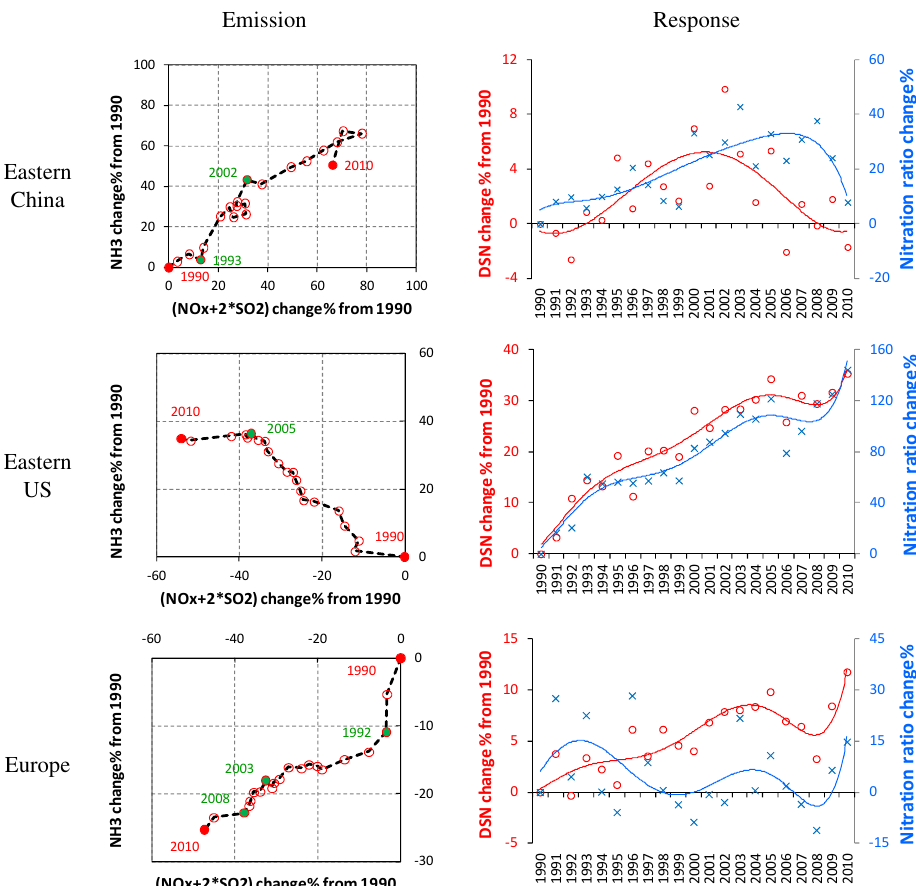
Figure 11. Changes in PM chemistry from modeling results (calculation based on molecular units; grid-averaged for three regions; (NO x + 2*SO 2 ) represents the amount of NH 3 needed for complete neutralization; DSN – degree of sulfate neutralization; nitration ratio = NO − concentration/NO x 3